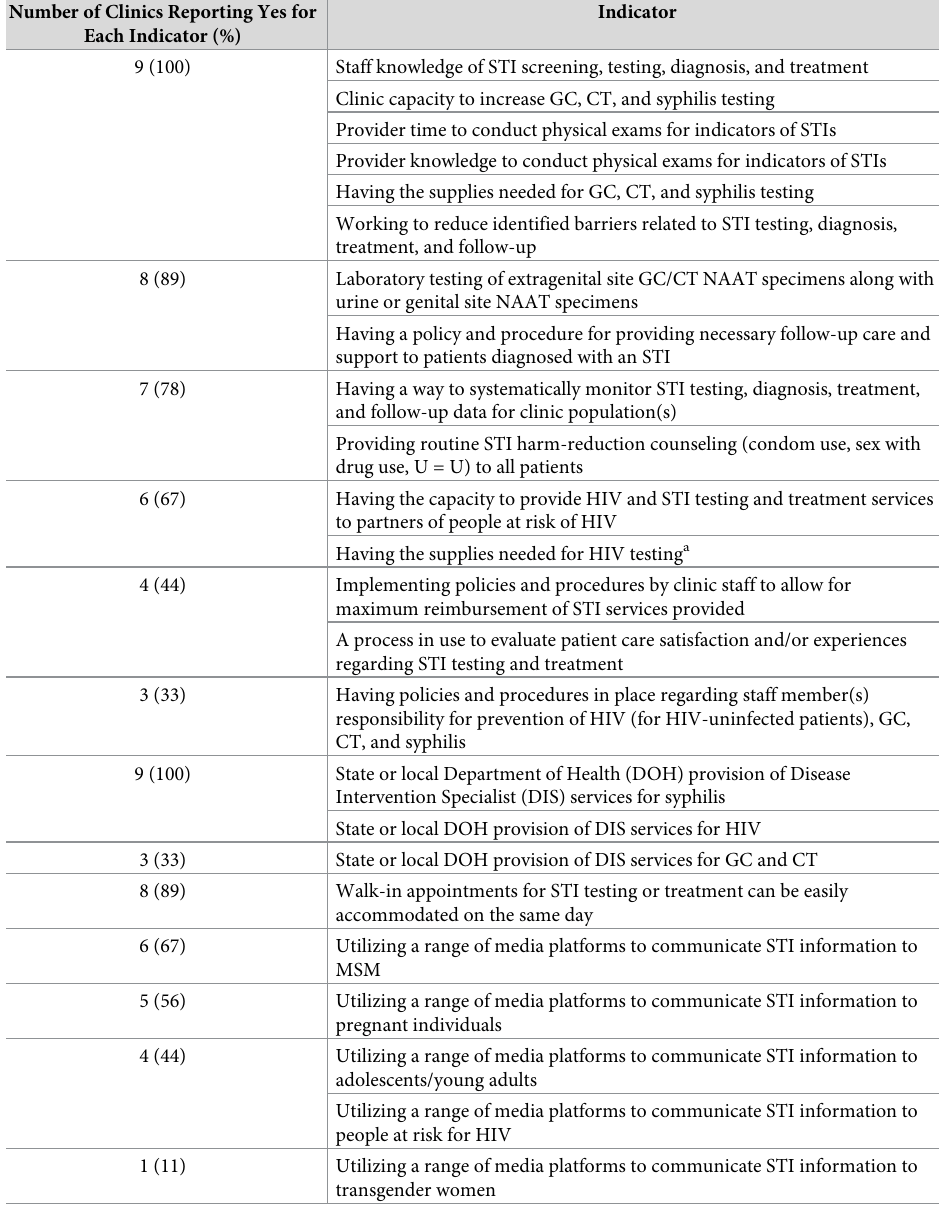
Table 3. STI screening readiness checklist. Number of Clinics Reporting Yes for Each Indicator (%)